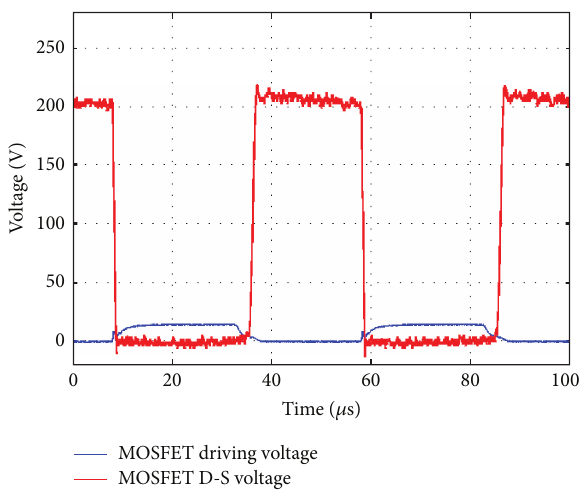
Figure 15: The Buck converter with LCD absorption circuit.